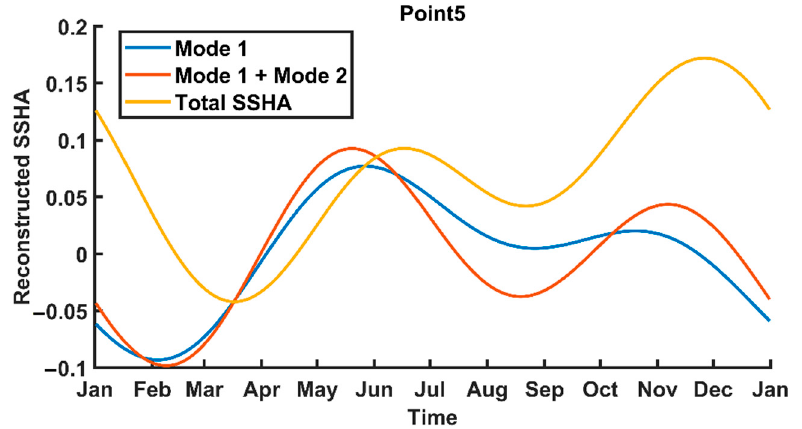
Figure 16. Climatology of reconstructed CEOF modes 1, the combination of mode 1 and 2, and the total SSHA.